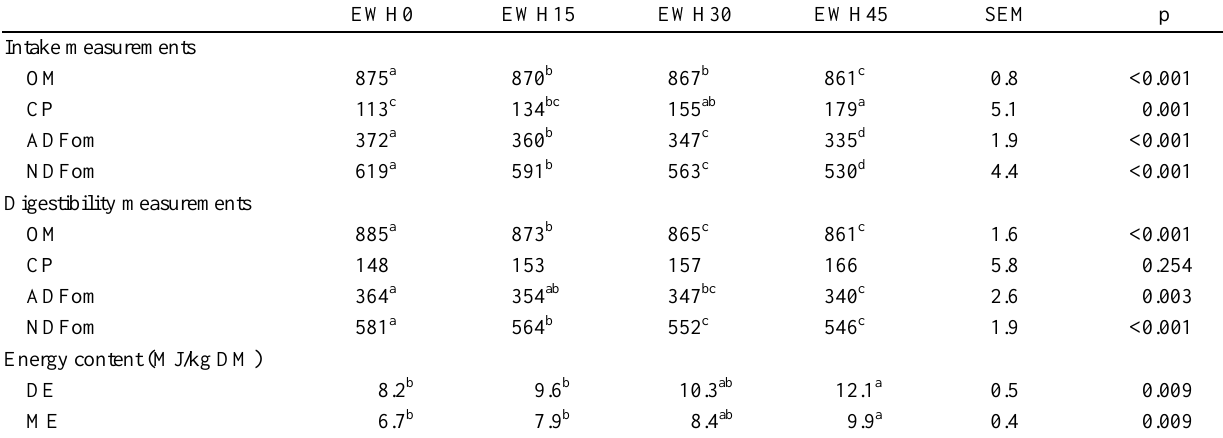
Table 2. Composition of diets from the intake and digestibility measurements (g/kg dry matter or as otherwise stated)